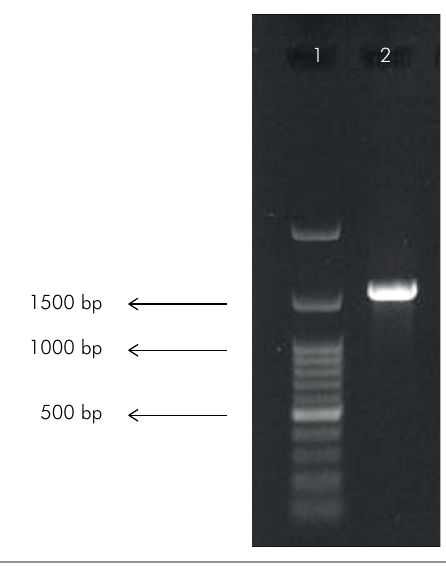
Figure 2. DNA amplification patterns obtained with universally targeting 16S rRNA on 2% agarose gel. Lane 1: Ladder 100 bp, Lane 2: an unknown